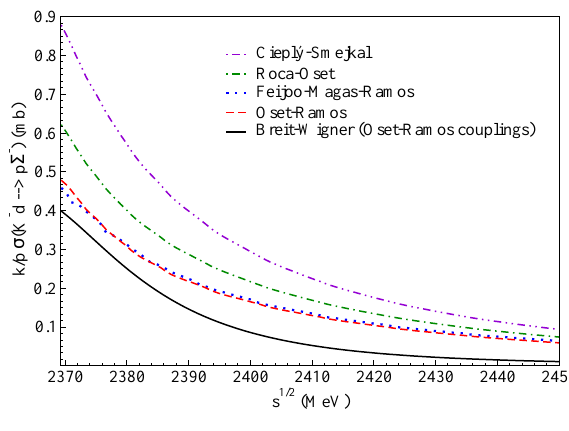
Figure 4. K − d → p Σ − cross sections ( k